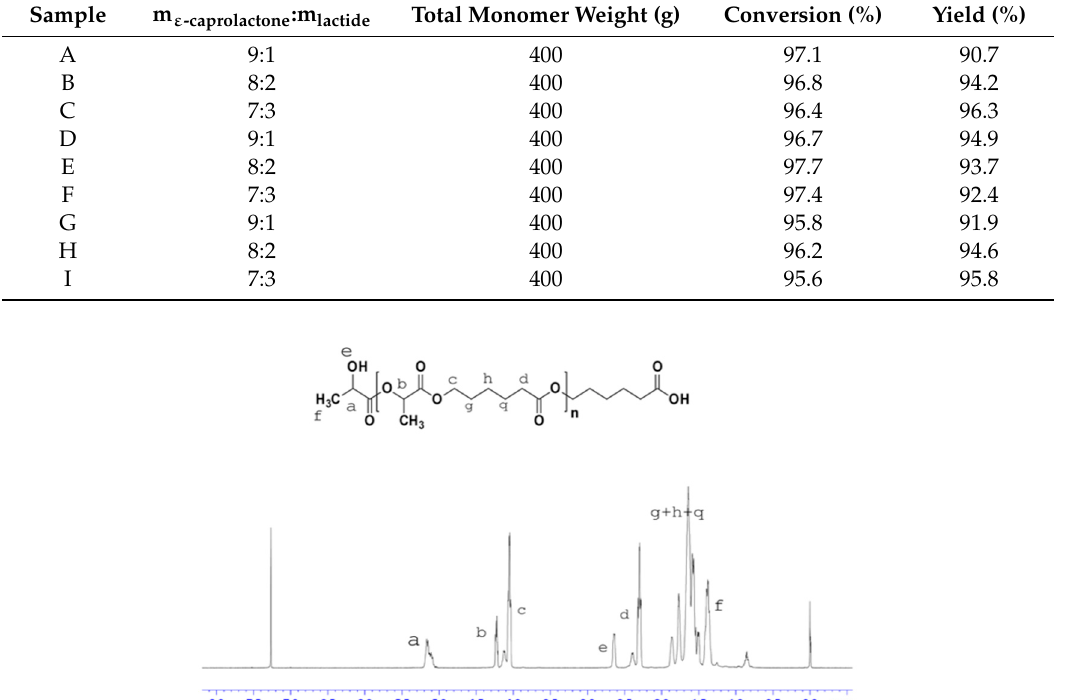
. Figure 6. 1 H-NMR spectrum of the poly(LA-CL) copolymer with glycol. Figure 7 shows that the gel permeation chromatography (GPC) curves of the copolymer samples each consist of only a single molecular weight distribution peak. These results indicate that the target